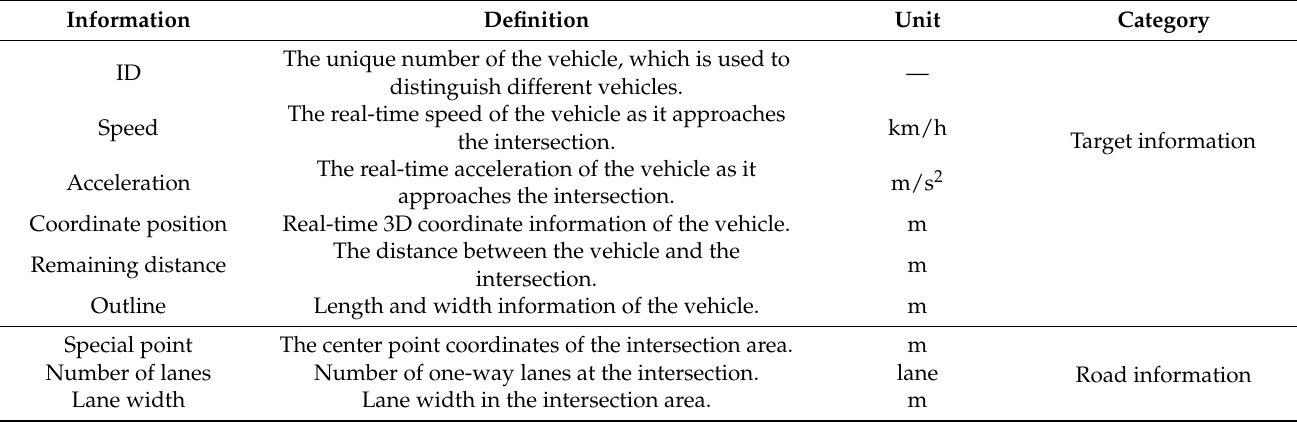
Table 1. Types of interaction information based on V2I.